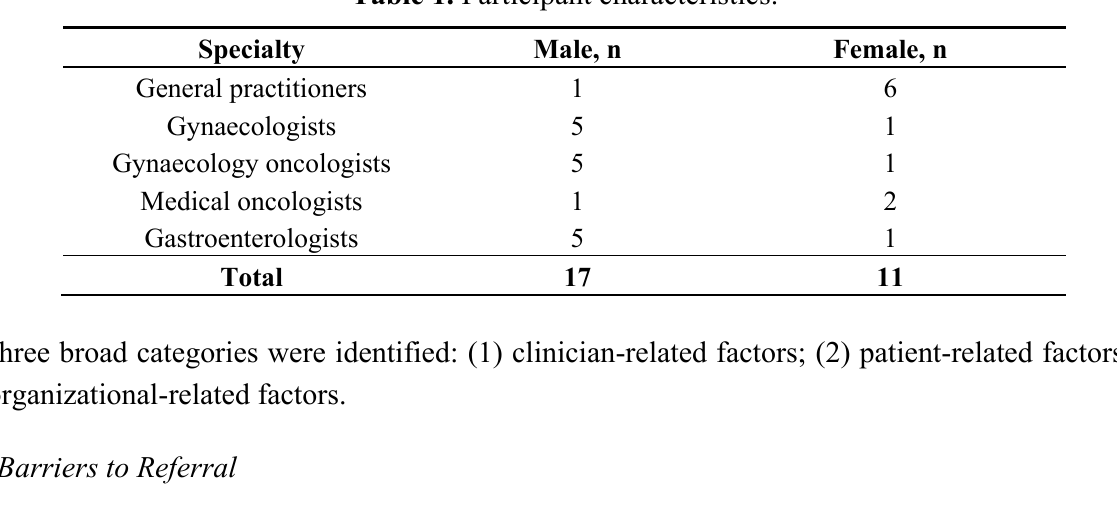
Table 1. Participant